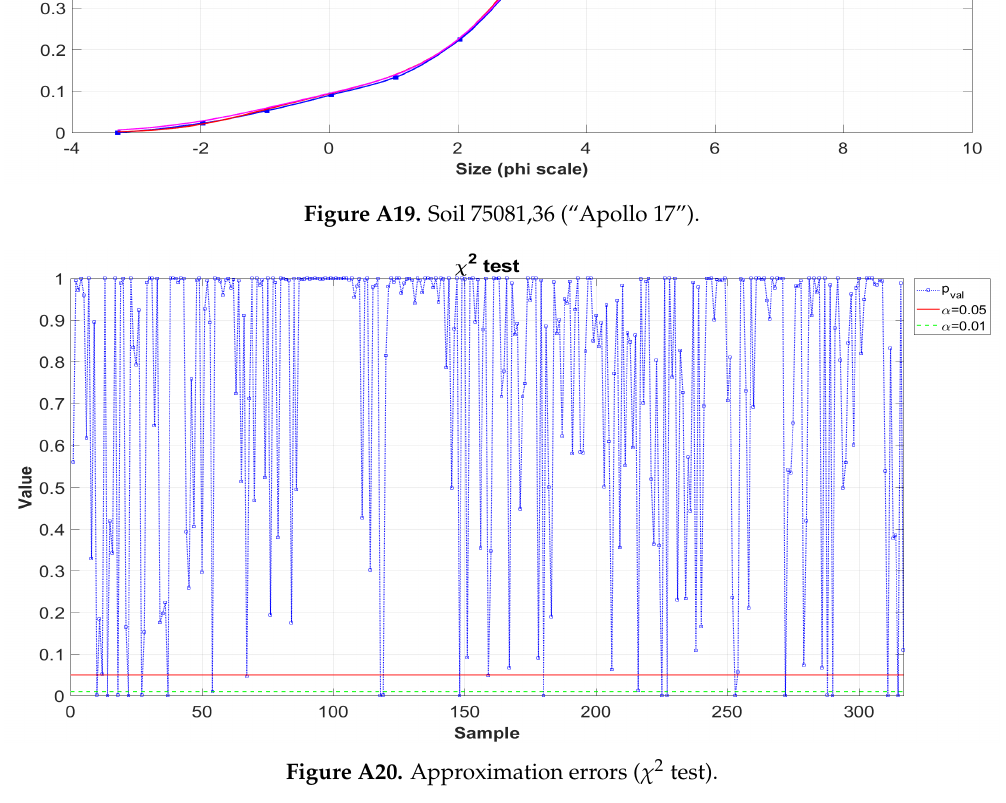
Figure A20. Approximation errors ( χ 2 test).